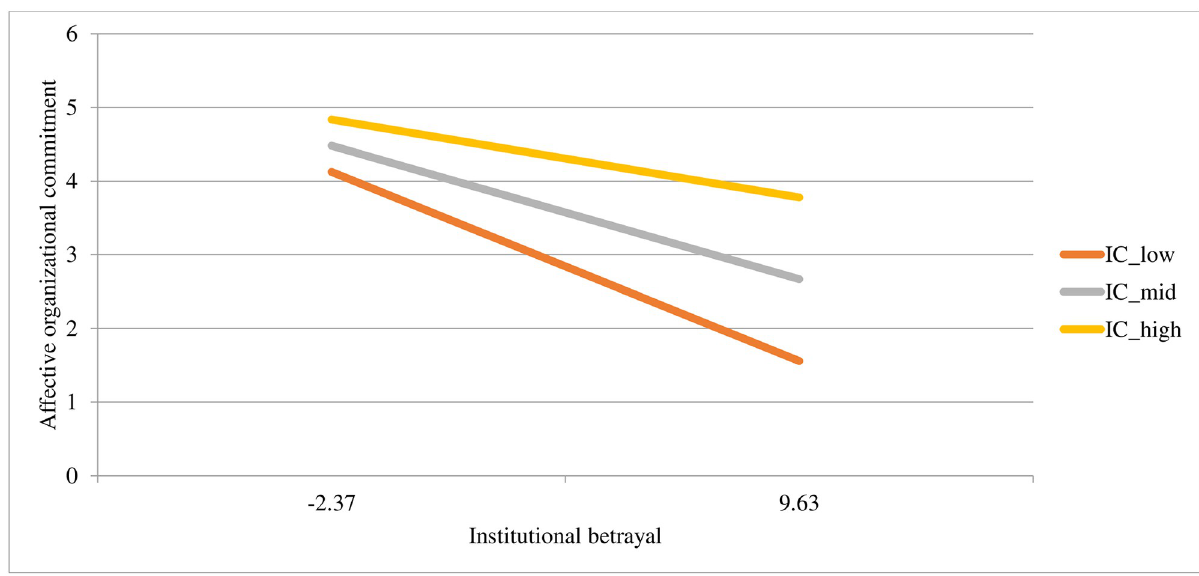
Fig 2. Associations between different levels of institutional courage (at -1SD, the mean, and +1SD) with affective organizational commitment at different levels of institutional betrayal (at -1SD and +1SD).